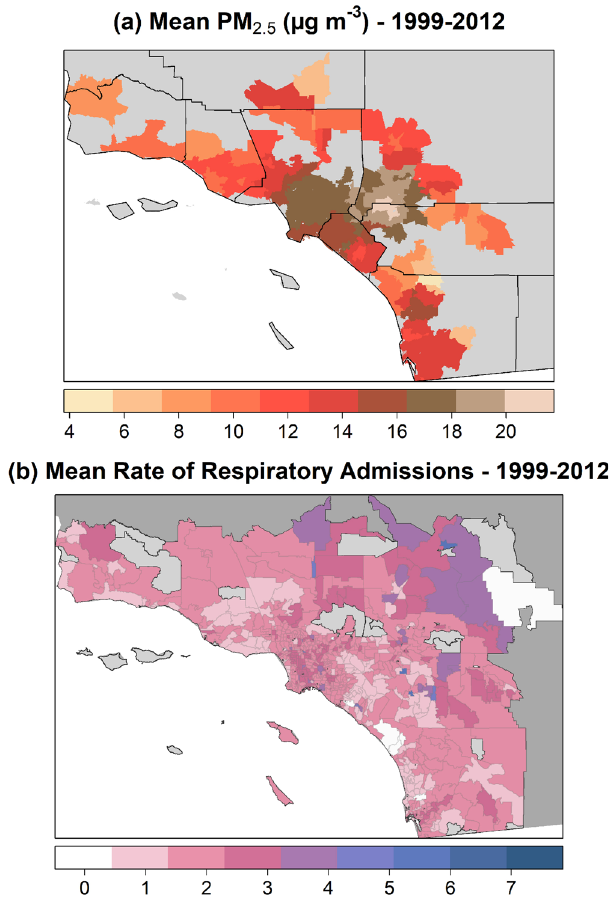
Fig. 2 Mean values of PM 2.5 and rate of respiratory admissions by ZIP code. a Mean PM 2.5 concentrations at available zip codes (county boundaries shown in black) and b mean rate of respiratory admissions (per 100,000 individuals) per zip code during 1999 – 2012 (summer months not considered).